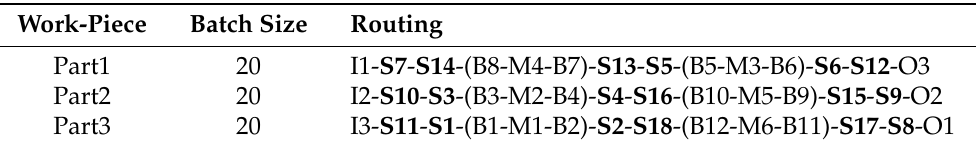
Table 1. The batch size and